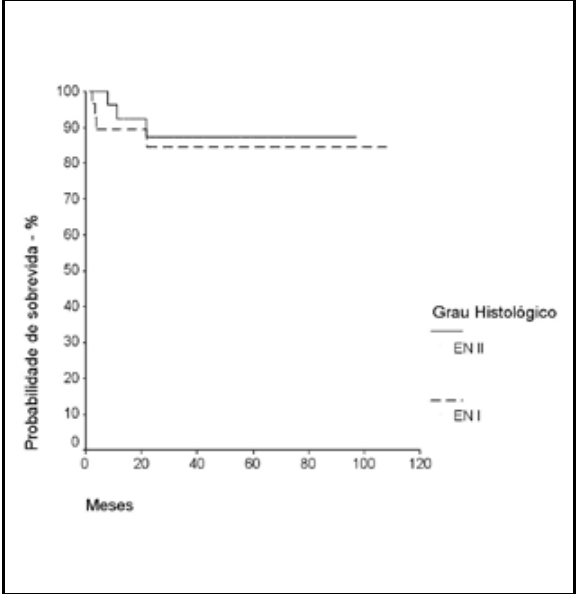
Figura 2 – Sobrevida global por grau histológico Figura 3 – Sobrevida livre de doença por grau histológico